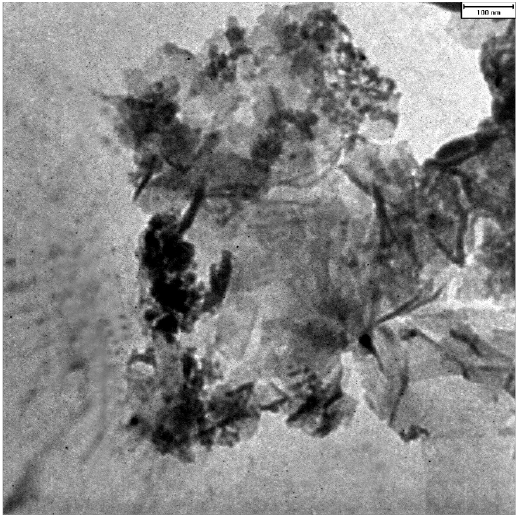
Figure 3. Scanning electron microscope and transmission electron microscopy images of zirconium magnetic nanocomposite. The FT-IR spectrum of the zirconium magnetic nanocomposite, as shown in Figure 4, proved the desired absorptions of the final product’s structure.